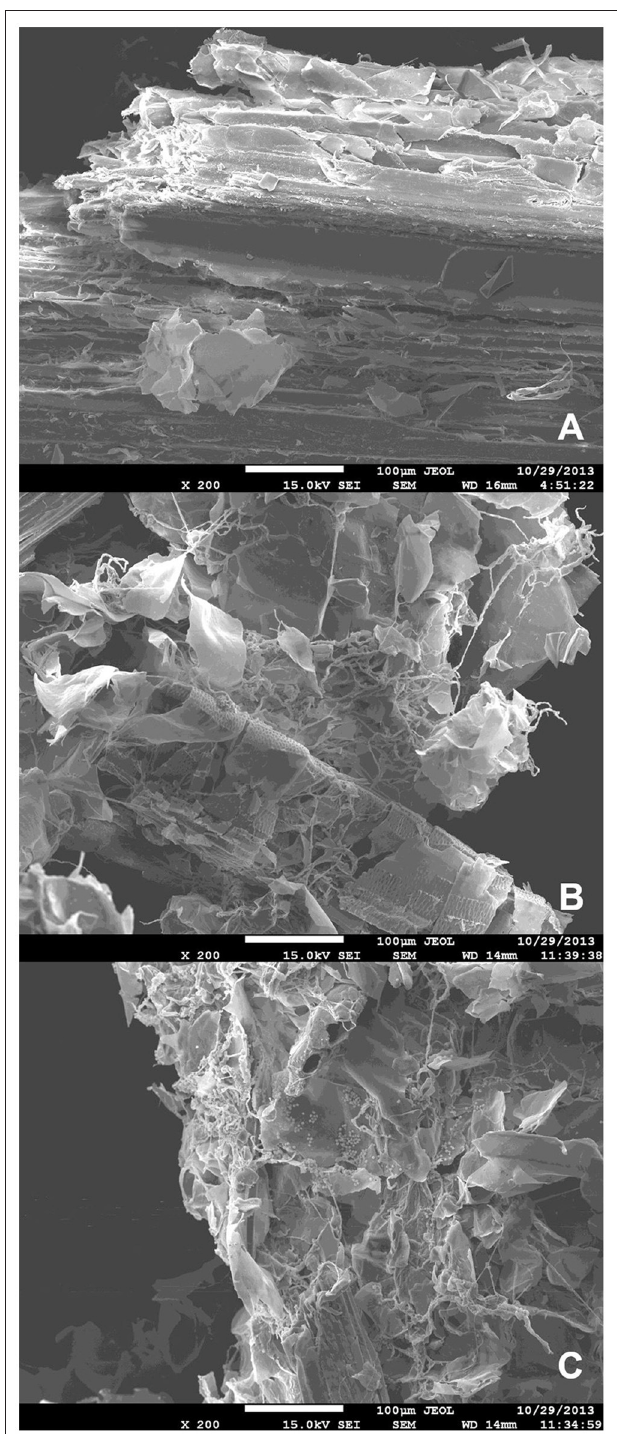
FIGURE 1 | Scanning electron microscopy images of (A) non-inoculated steam-exploded sugarcane bagasse parenchyma in liquid minimal medium culture; (B) steam-exploded sugarcane bagasse parenchyma in liquid minimal medium culture following 36h incubation with A. tamarii BLU37; (C) steam-exploded sugarcane bagasse parenchyma in liquid minimal medium culture following 48h incubation with A. tamarii BLU37. Bars = 100 µ m; 200X